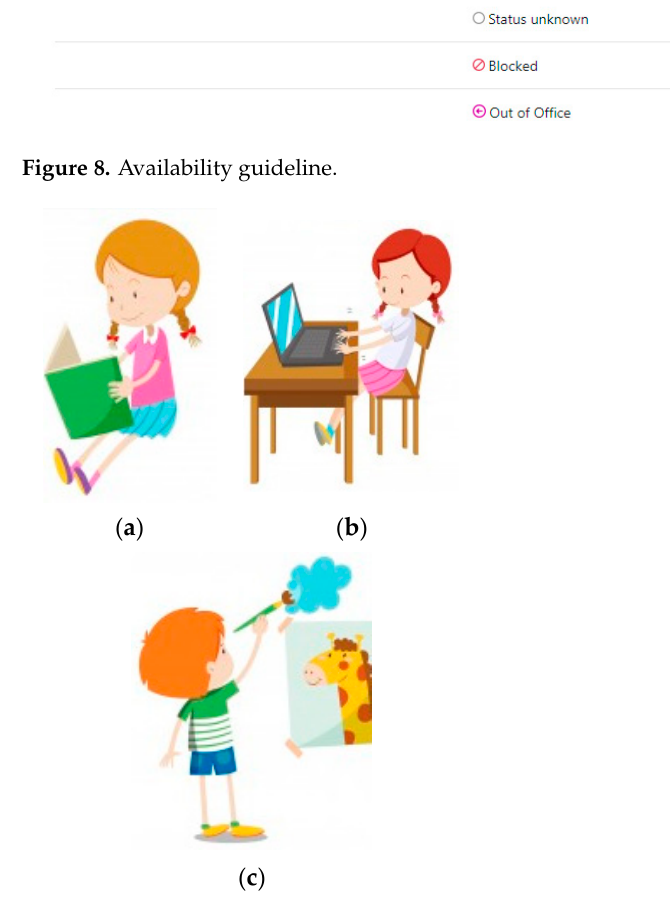
Figure 8. Availability guideline.